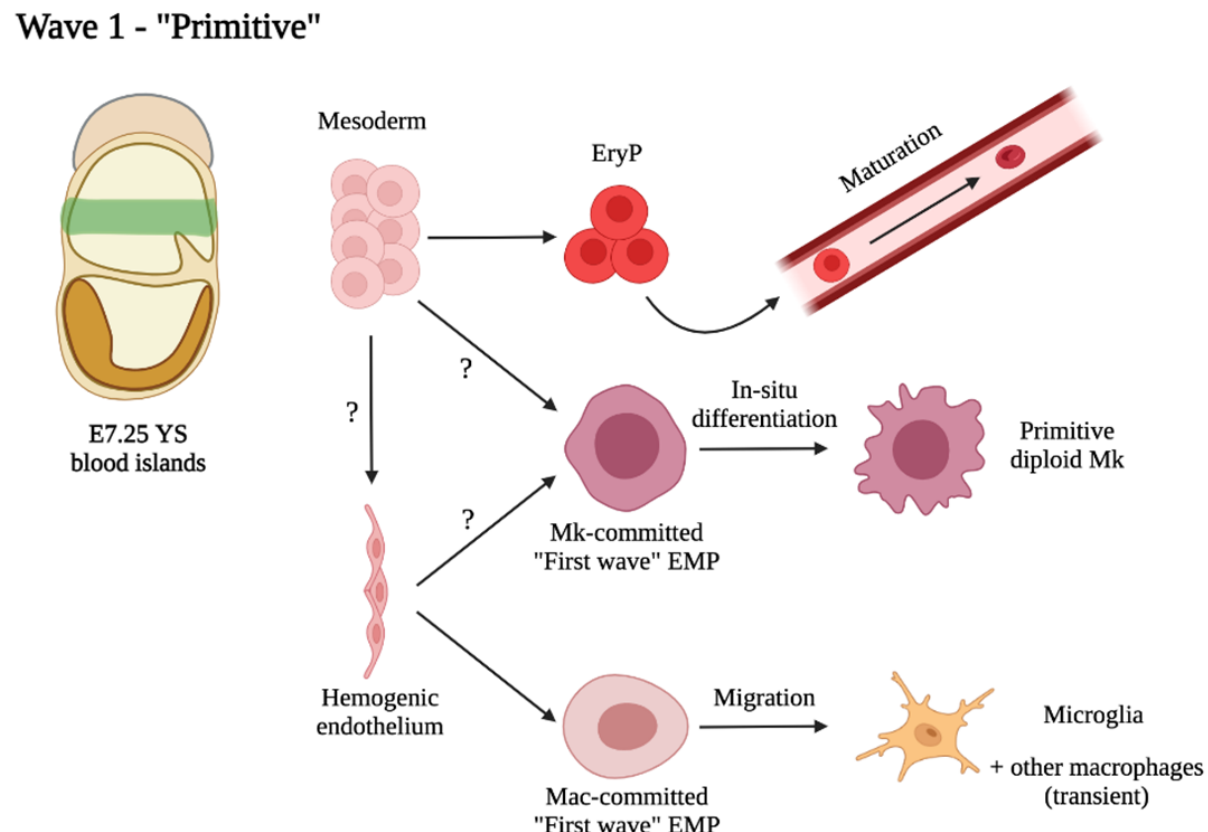
Figure 1. Proposed schematic depicting the primitive wave of hematopoiesis. Mac progenitors are first detected in the YS starting from E7.25 in the mouse [74], in a spatial and temporal fashion overlapping with that of the primitive erythroid cells and Mk. The very first Mac, however, are derived from the mother [94]. Shortly afterwards, monopotent Mac precursors appear in the YS and differentiate from c-Kit + progenitors bypassing monocyte intermediates [94]. Mac are completely absent in Runx1 -/- ES cell cultures and embryos [89,95], so it would appear that all Mac generated in the embryo originate through EHT. The first Mac wave arises independently of c-Myb [96], similar to the progenitors generating the first Mk. What is the progenitor of this primitive wave of embryonic Mac? As c-Kit in the YS is a marker of EMPs [78], there could be a first wave of “early” EMPs that are fated to differentiate to Mac [97]. The role of these primitive Mac was long believed to consist essentially in tissue remodeling and phagocytosis of dead cells. As early as E9, primitive Mac colonize all tissues, starting from the brain [98]. They comprise the predominant Mac population in most organs until E13.5, but are later replaced by monocyte-derived Mac, with one notable exception: brain microglia [97]. Although it is now accepted that microglia in mammals remain of extraembryonic origin throughout life with little/no contribution from monocyte-derived Mac [99], their